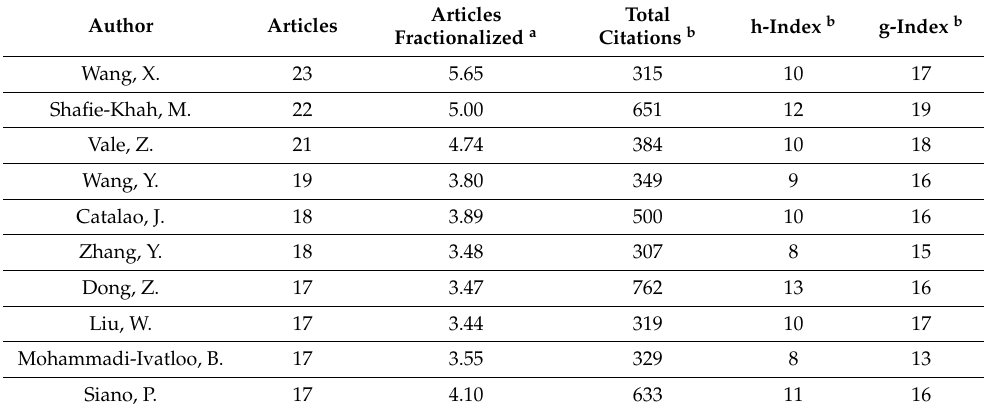
Table 3. Main authors. Source: own study using data from